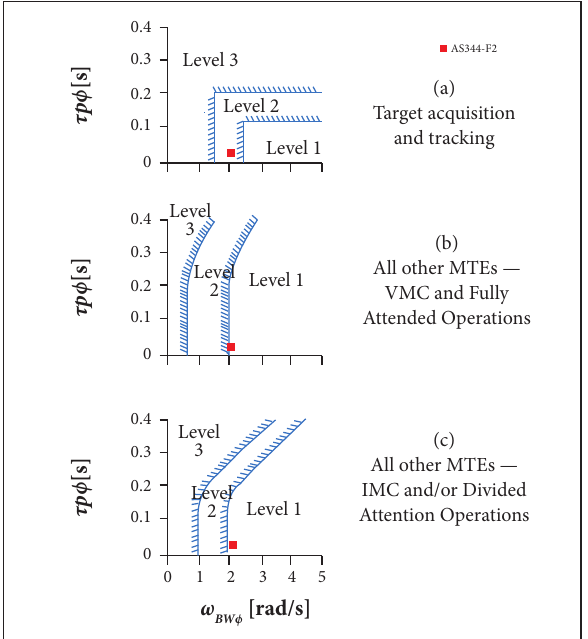
Figure 15. Flying qualities levels – AS355-F2 lateral response (ADS-33E-PRF